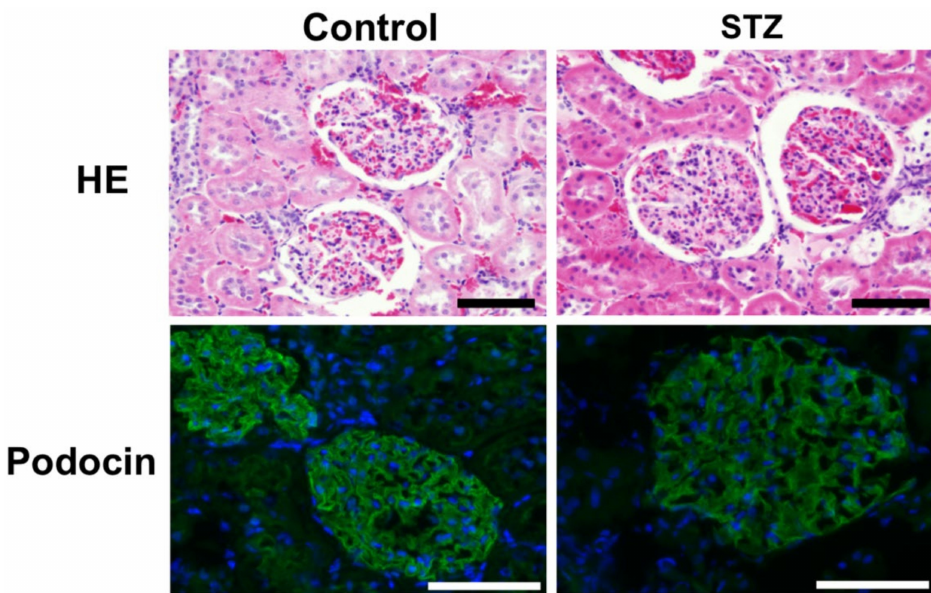
Figure 3. Morphological changes in the glomerulus of diabetic rats at 3 months after injection of streptozotocin (STZ). Diabetes was induced in male Wistar rats by single intraperitoneal injection of 60 mg / kg body weight of STZ. Control rats were intraperitoneally injected with 1 mL of 0.1% acetic acid. Three-millimeter-thick para ffi n sections of removed renal cortex were stained with hematoxylin and eosin (HE) or Masson’s trichrome stain. The kidney sections were incubated with anti-podocin and then incubated with Alexa Fluor 488 anti-rabbit IgG. Scale bar indicates 25 µ